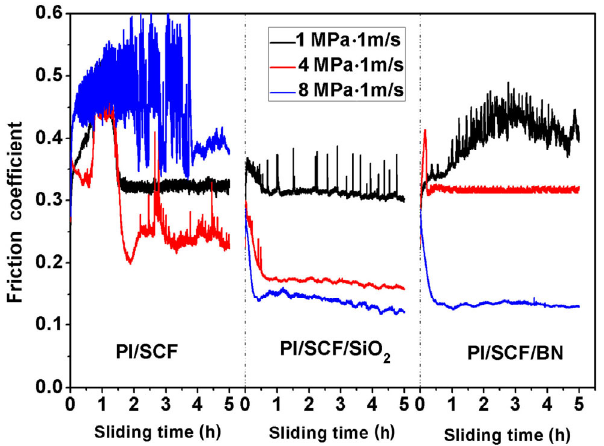
Fig. 11 Evolution of friction coefficient at different sliding time when PI/SCF, PI/SCF/SiO 2 , and PI/SCF/BN were slid against Al 2 O 3 at 1, 4, and 8 MPa·1m/s.